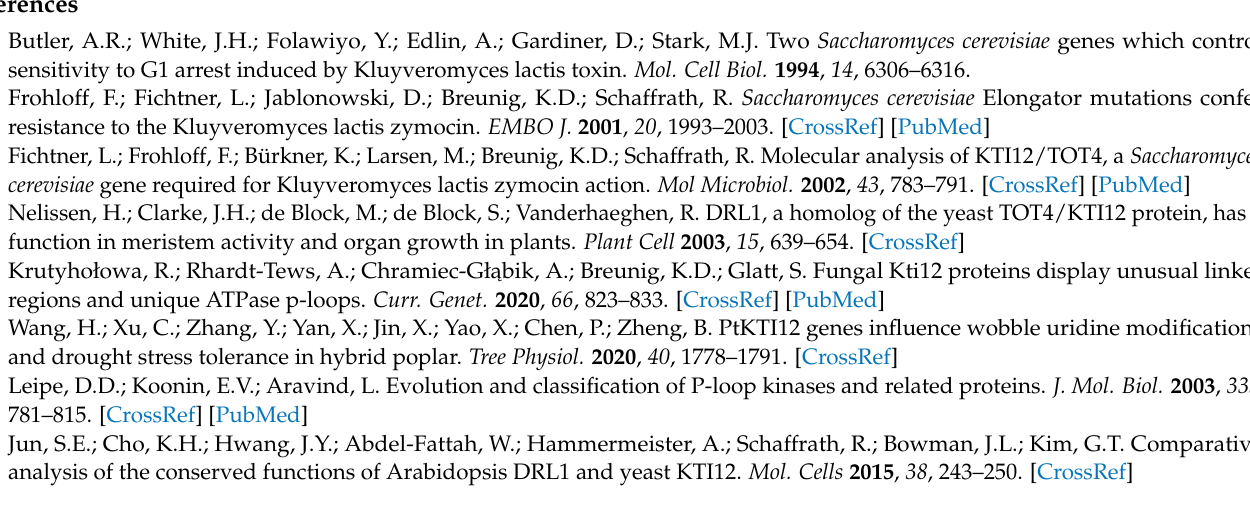
Figure S2: Identification of GhKTI12 transgenic plants, Figure S3: Morphology analysis and stem cell observation of GhKTI12 transgenic plants, Figure S4: Observation of morphology and capsule number in GhKTI12 transgenic plants. Figure S5: Analysis of differentially expressed genes (DEGs) in GhKTI12 transgenic plants, Figure S6: qRT-PCR analysis of cellular protein genes in GhKTI12 transgenic plants and WT plants, Figure S7: qRT-PCR analysis of downregulated genes related to plant flowering in GhKTI12 transgenic plants and WT plants, Table S1: List of primers used in this study, Table S2: Comparison of biomass production, and seed yield between GhKTI12 transgenic and WT tobacco plants, Table S3: Core DEGs in WT and GhKTI12 transgenic samples, Table S4: Up- and downregulated DEGs in WT and GhKTI12 transgenic samples, Table S5: Enriched GO terms in upregulated DEGs in WT and GhKTI12 transgenic samples, Table S6: Enriched GO terms in downregulated DEGs in WT and GhKTI12 transgenic